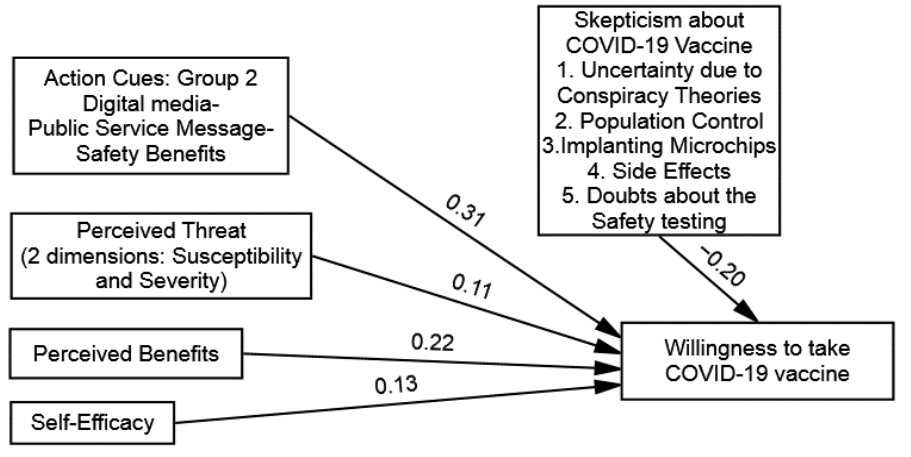
Figure 3. Structural model of group 2: Digital Media–Public Service Message–Safety Benefits.